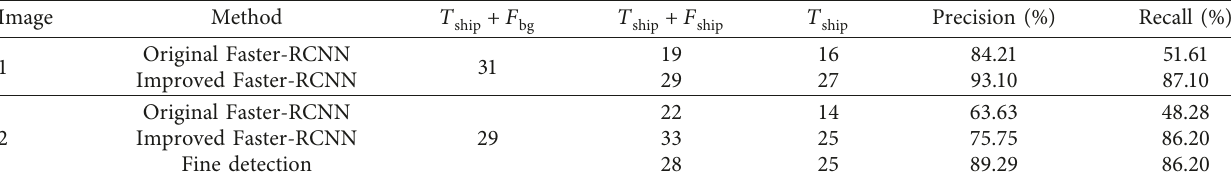
Table 8: Comparison of ship target detection